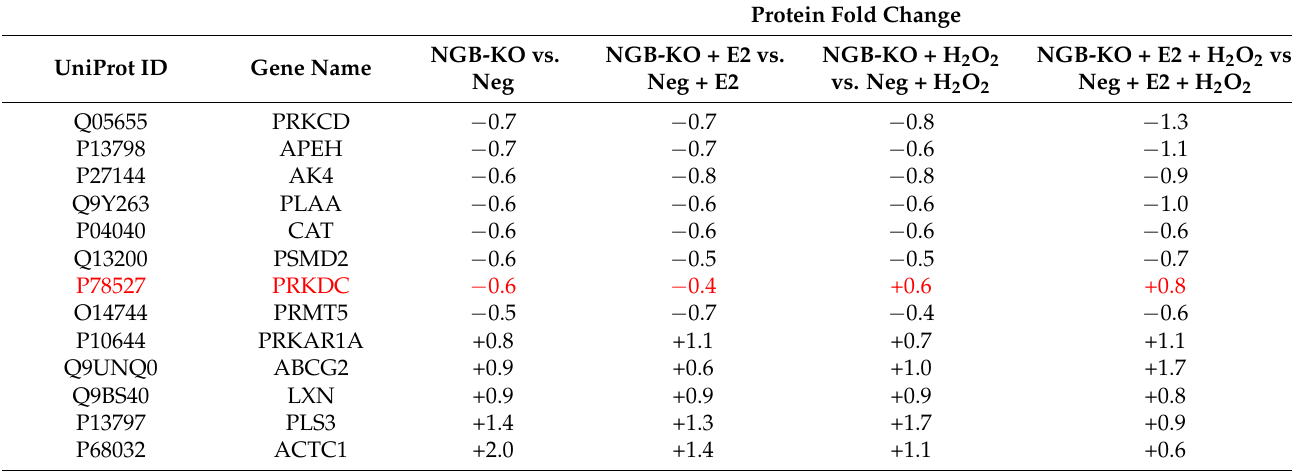
Table 3. Cont. Protein Fold Change